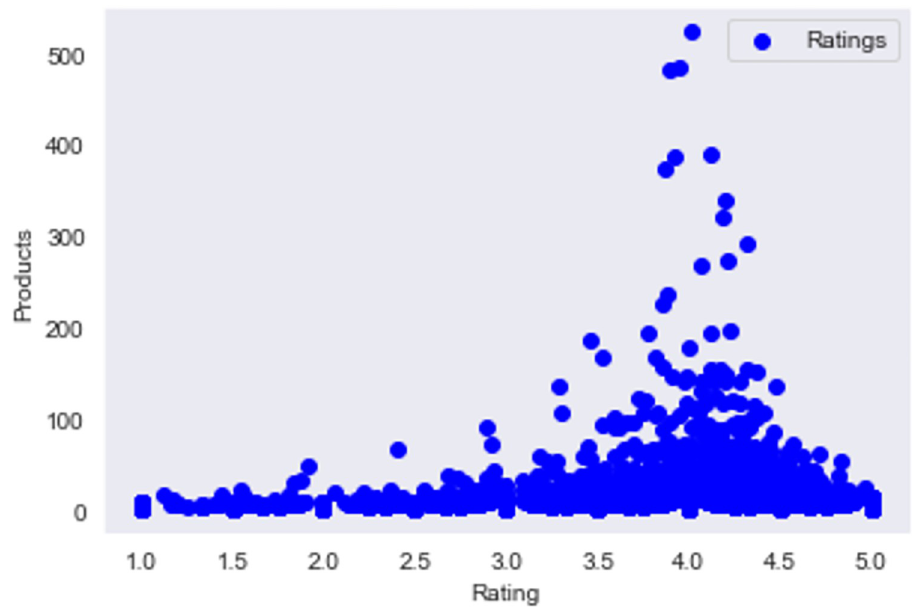
Fig 10. The average rating for products in BE-dataset.